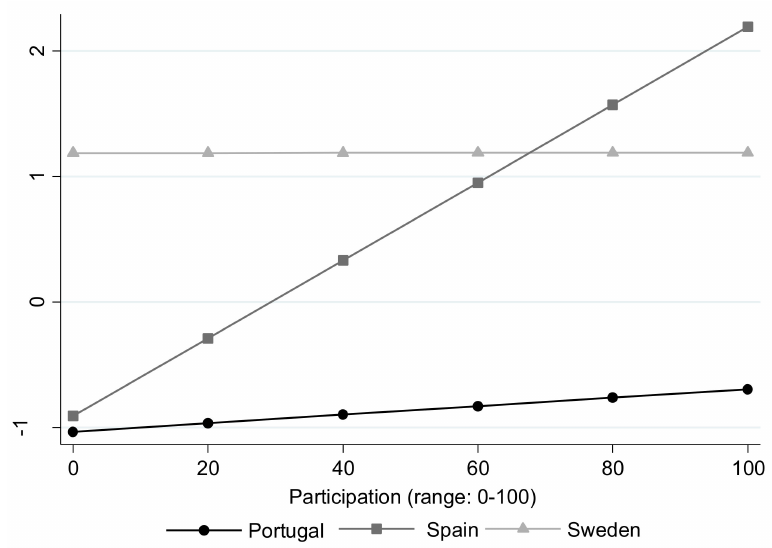
Figure 2. Country and participation interaction on the change in QoL. Linear regression model (CASP-12) adjusted by all predictor